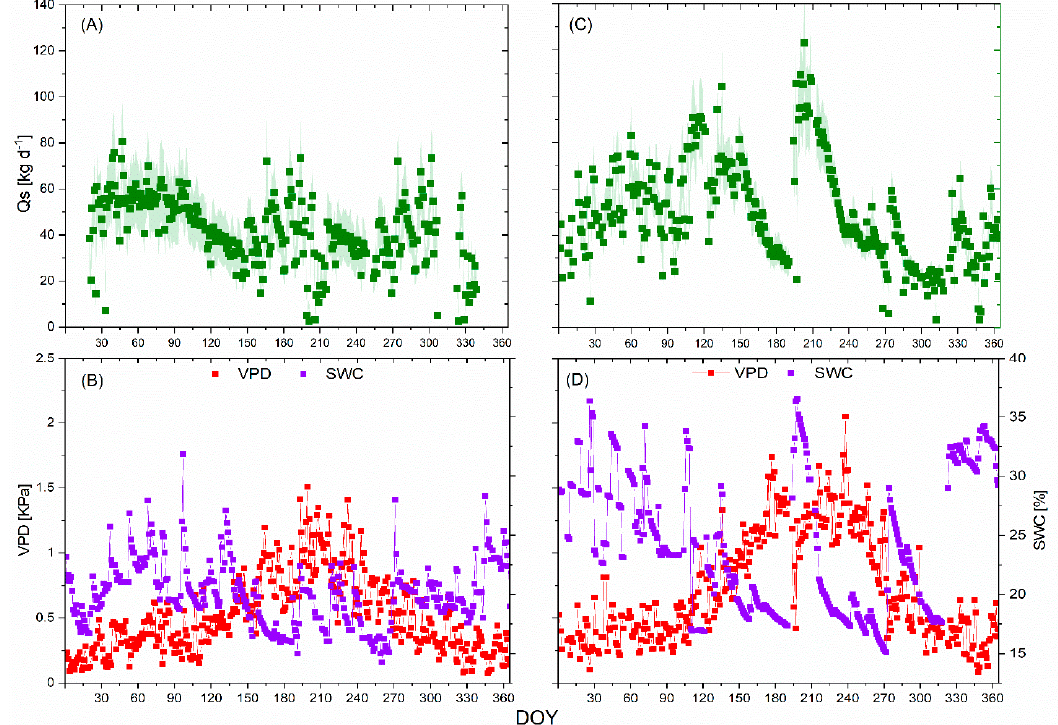
Figure 3. Seasonal variation of sap flow rate per sapwood area (Qs; kg d − 1 ), VPD, and SWC during the dry study period ( A , B ) and wet study period ( C , D ). In plots ( A , C ) symbols represent mean values of daily Qs and shaded bands represent ± SE ( n = 5 trees).